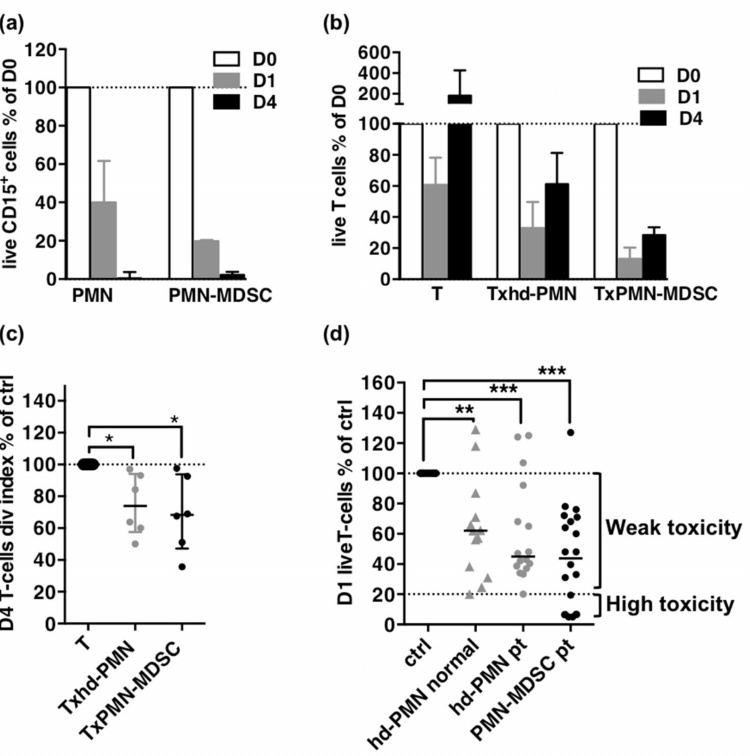
Figure 2. Suppression as direct cytotoxicity on T cells. ( a ) Follow-up of CD15 + cells during the proliferation assay. Percentages of day 0 absolute counts of live CD15 + cells on day 1 and day 4. ( b ) Follow-up of T cells during the proliferation assay. Percentages of day 0 absolute counts of T cells on day 1 and day 4. ( c ) Proliferation of T cells on day 4 as percentage of control T cells division index. For ( a – c ): high-density PMNs, n = 6; PMN-MDSCs, n = 5. ( d ). Cytotoxicity of high-density PMNs from healthy donor (hd-PMN HD, n = 13) or patients (hd-PMN pt, n = 16) and of PMN-MDSCs ( n = 20) as percentages of control T cells survival in overnight co-cultures. The minimum value reached by high-density PMNs (20%) indicated by a dotted line constitute the threshold between weak and high cytotoxicity for PMN-MDSCs. Medians and IQR for ( a – c ); median for ( d ). p -values of Mann-Whitney U -tests for ( a , b ) and of Wilcoxon matched pairs-tests for ( c , d ) are indicated on top of pairs: *, p < 0.05; **, p < 0.01; *** p <